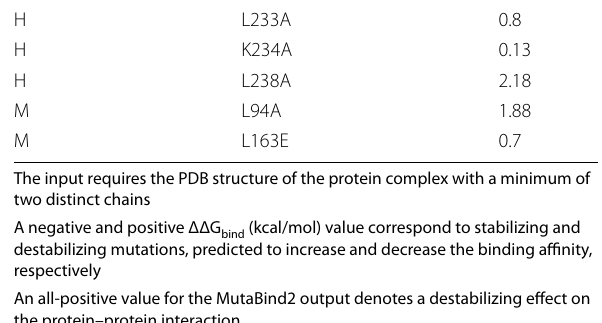
Table 4 mmCSM-PPI-predicted binding affinity change upon residue mutation